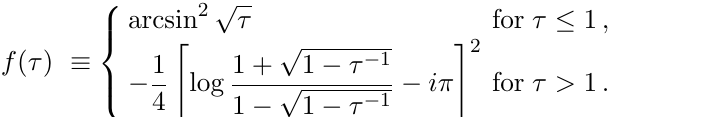
for the contributions of top quarks 1 = 2 = 4 m 2 in the CP-even H and CP-odd A t (cid:8)